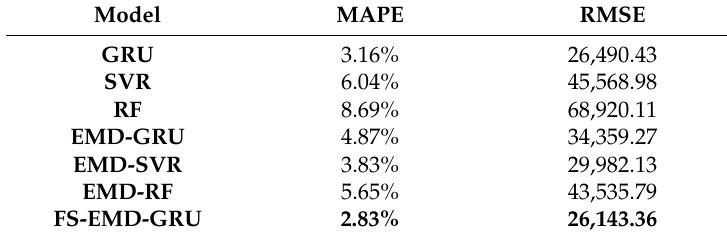
Table 5. Comparison of dataset prediction results in Northwest China.